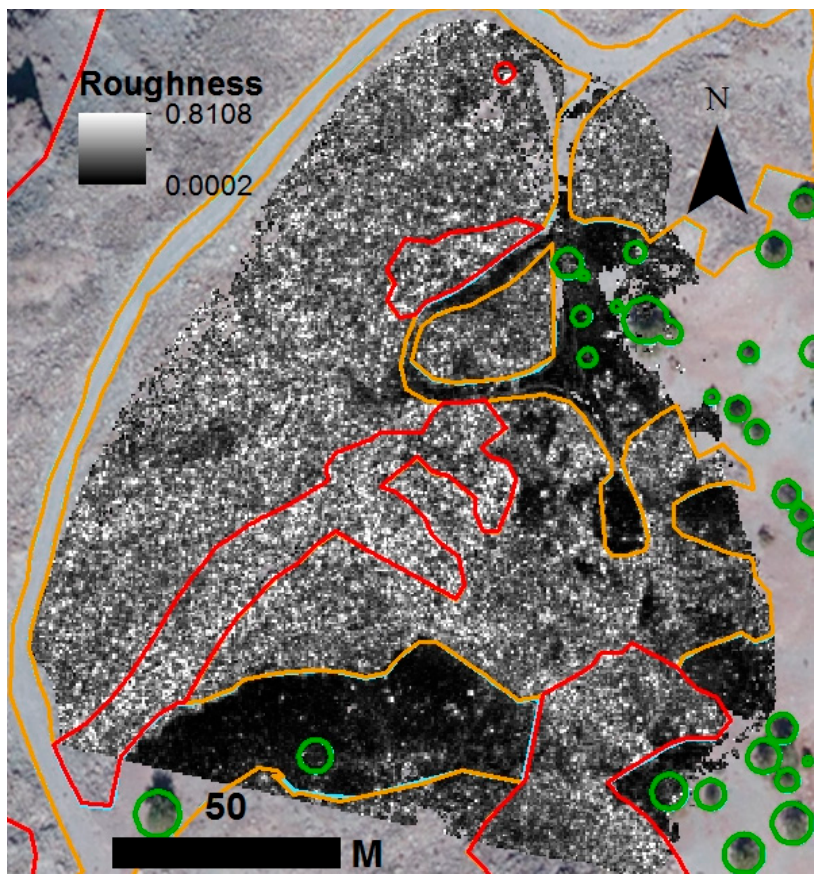
Figure 6. Roughness calculation with kernel size = 2 m of “the Bowl” study area. Particle size category boundaries are overlaid with the colors corresponding to those in Table 2.